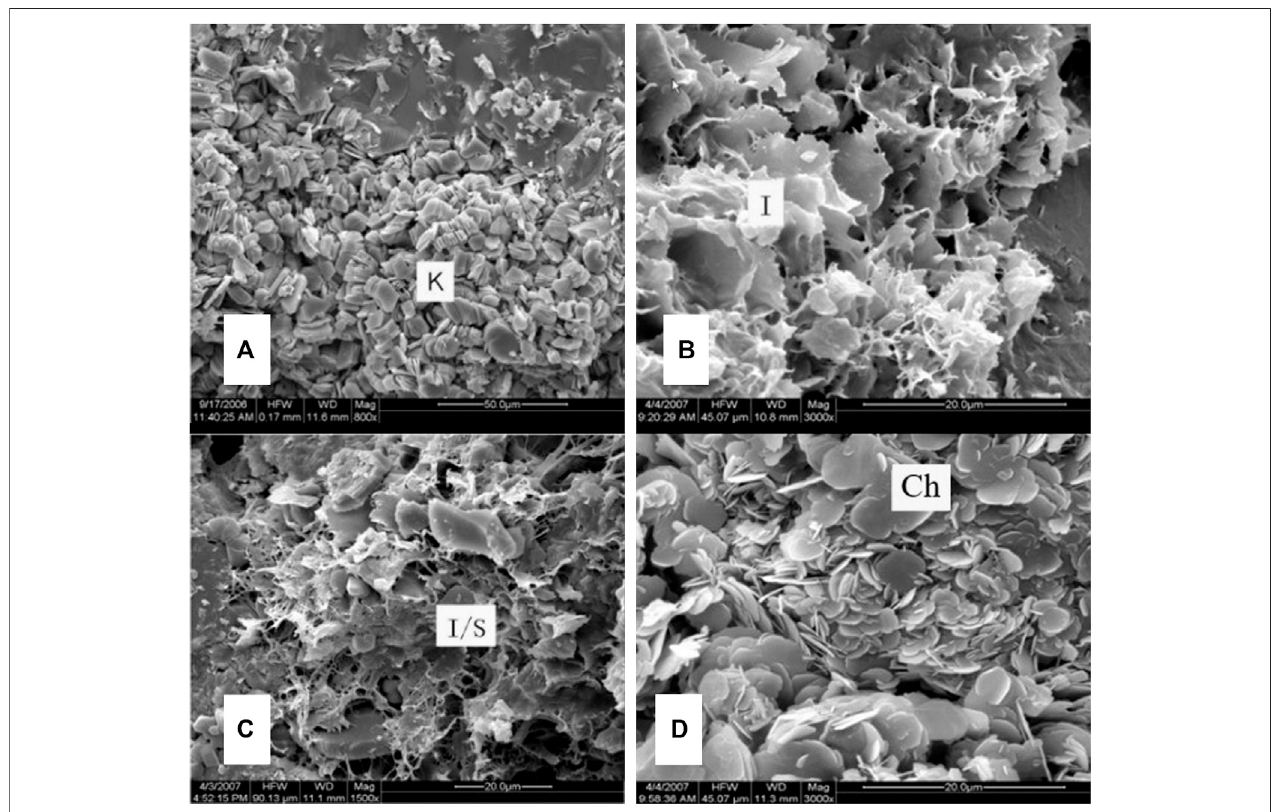
FIGURE 3 | SEM images of clay minerals [ (A) kaolinite, (B) illite, (C) illite smectite mixed layer, (D) chlorite].